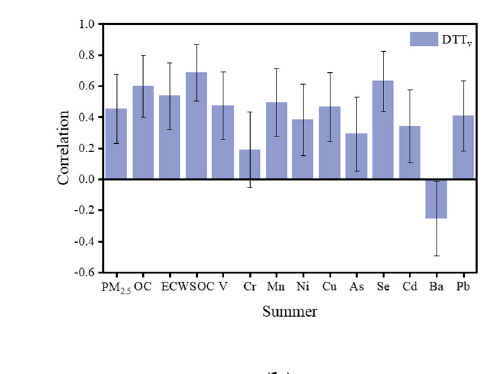
Figure 6. Correlations between DTT v with OC, EC, WSOC, metals, and PM 2.5 mass concentrations in spring ( a ), summer ( b ), autumn ( c ), and winter ( d ).